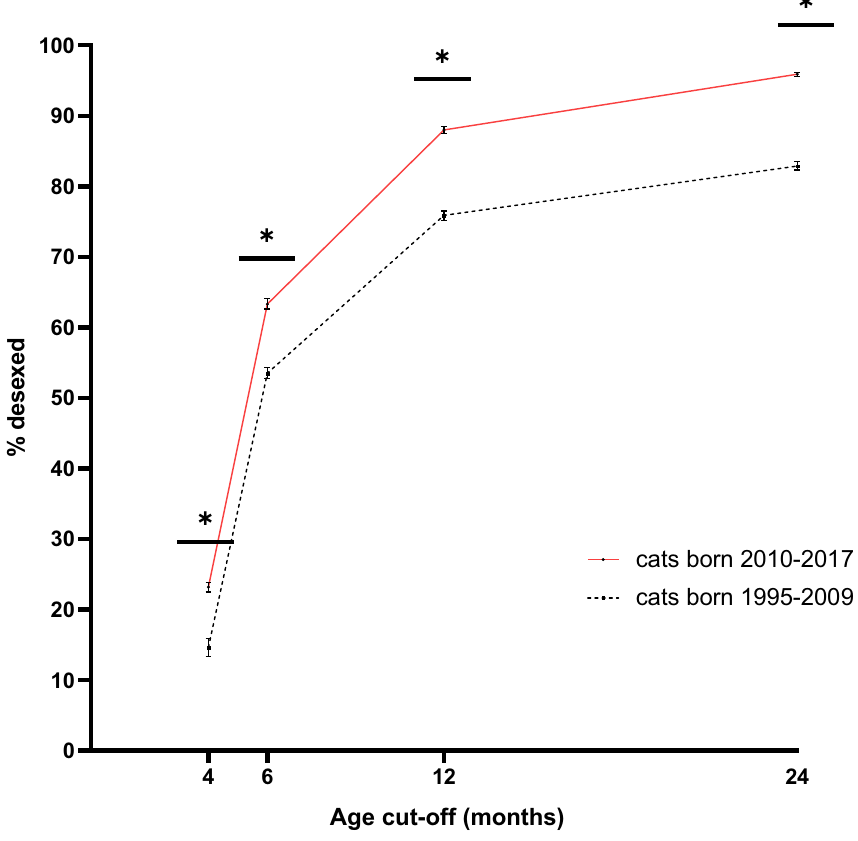
Figure 2. Comparison of the proportion of cats desexed before 4, 6, 12 or 24 months of age in Australian cat cohorts born in consecutive time periods. Vertical bars represent CI 95 . * denotes p <